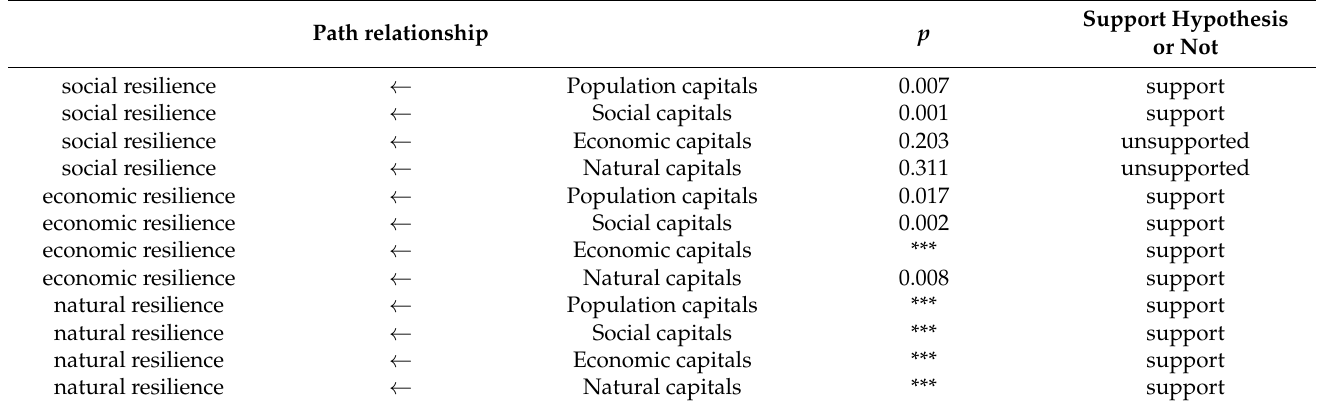
Table 4. Structural equation model analysis